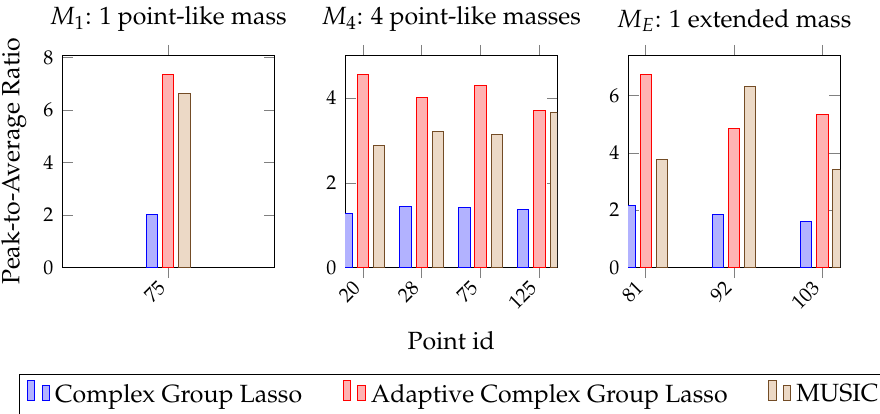
Figure 8. Peak-to-Average Ratio with Complex Group Lasso, Adaptive Complex Group Lasso and full-array MUSIC for the three damage